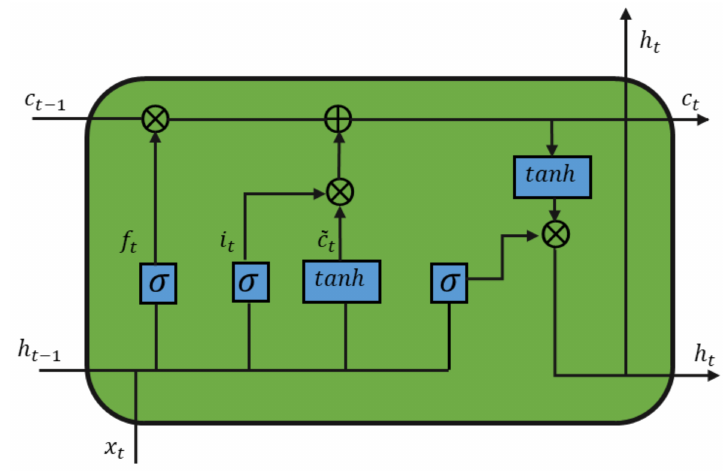
Figure 3. Internal structure of LSTM cell.